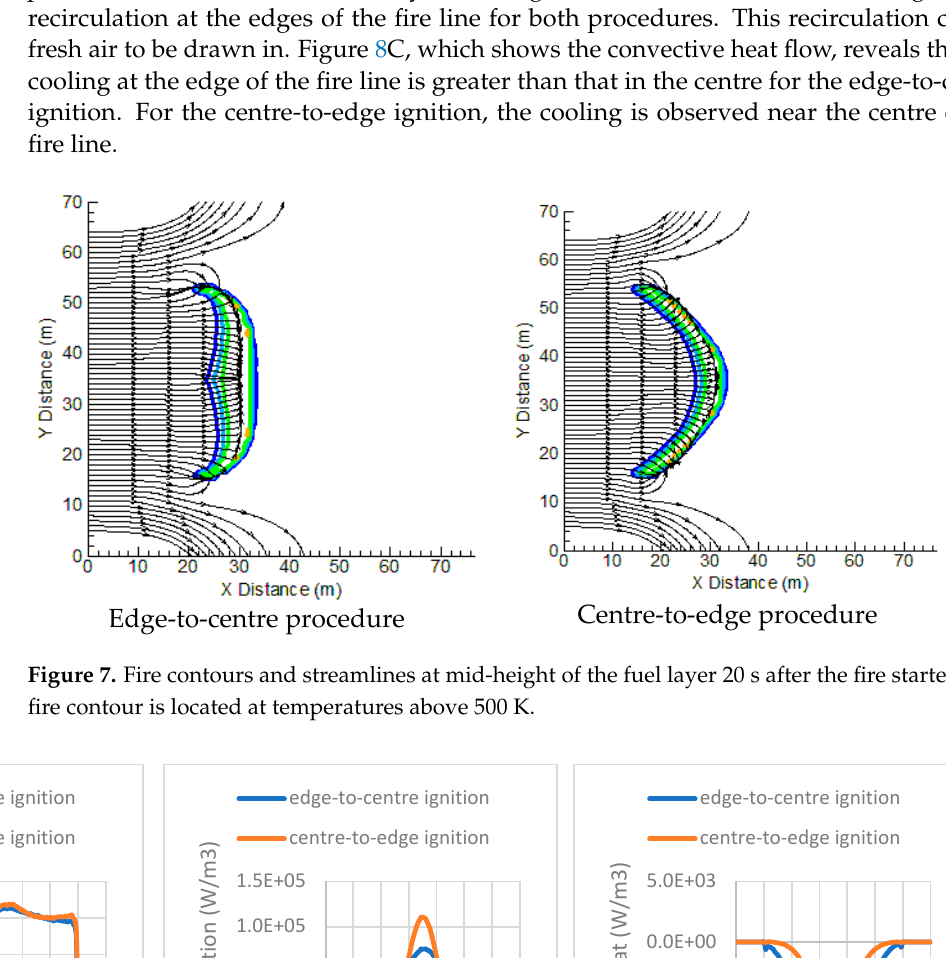
( D ) Figure 6. Comparison of predicted fire front positions and heat release rates for the two ignition